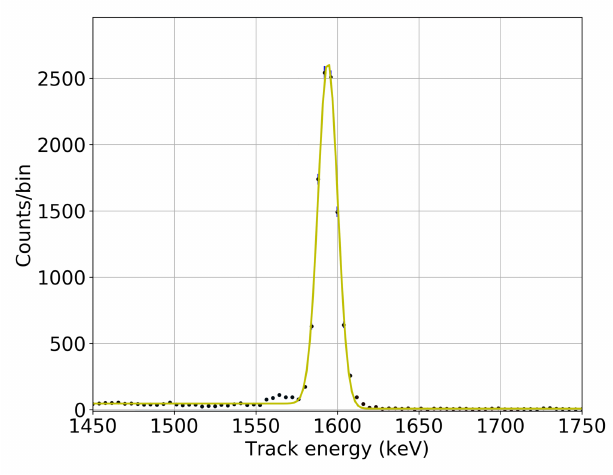
Figure 10 . Energy spectrum of e − e + pairs around the 1.6 MeV double escape peak, fitted according to equation